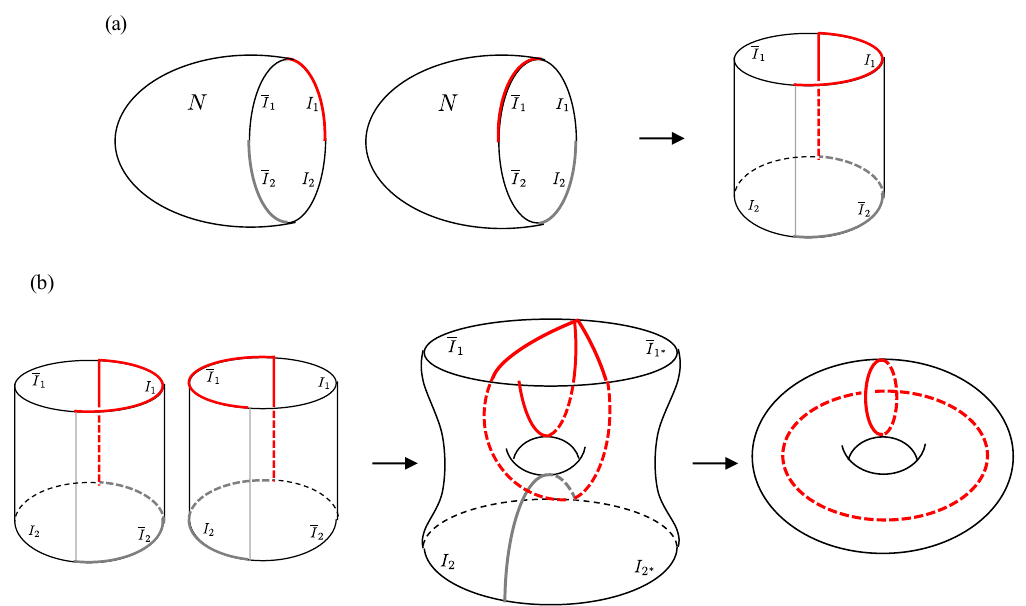
Figure 6 . Every time we glue surfaces along I 1 and I 1 , we introduce the twist by the fermion parity in the resulting surface along the gluing interval. (a): when we glue two copies of N to take the square of (cid:26) T 1 , we introduce the fermion parity twist along the red line in the resulting cylinder. The induced spin structure is Ramond. (b): when we glue four copies of N to take the fourth power of (cid:26) T 1 , we introduce the fermion parity twist along the red line in the resulting punctured torus. If we close the puncture by taking the trace, the induced spin structure on the torus is (R, R).